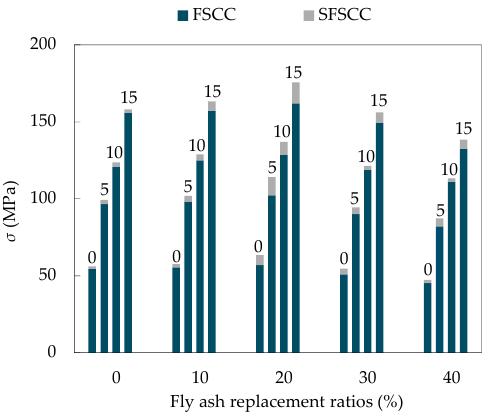
Figure 12. SCC peak stress under different confining pressures.